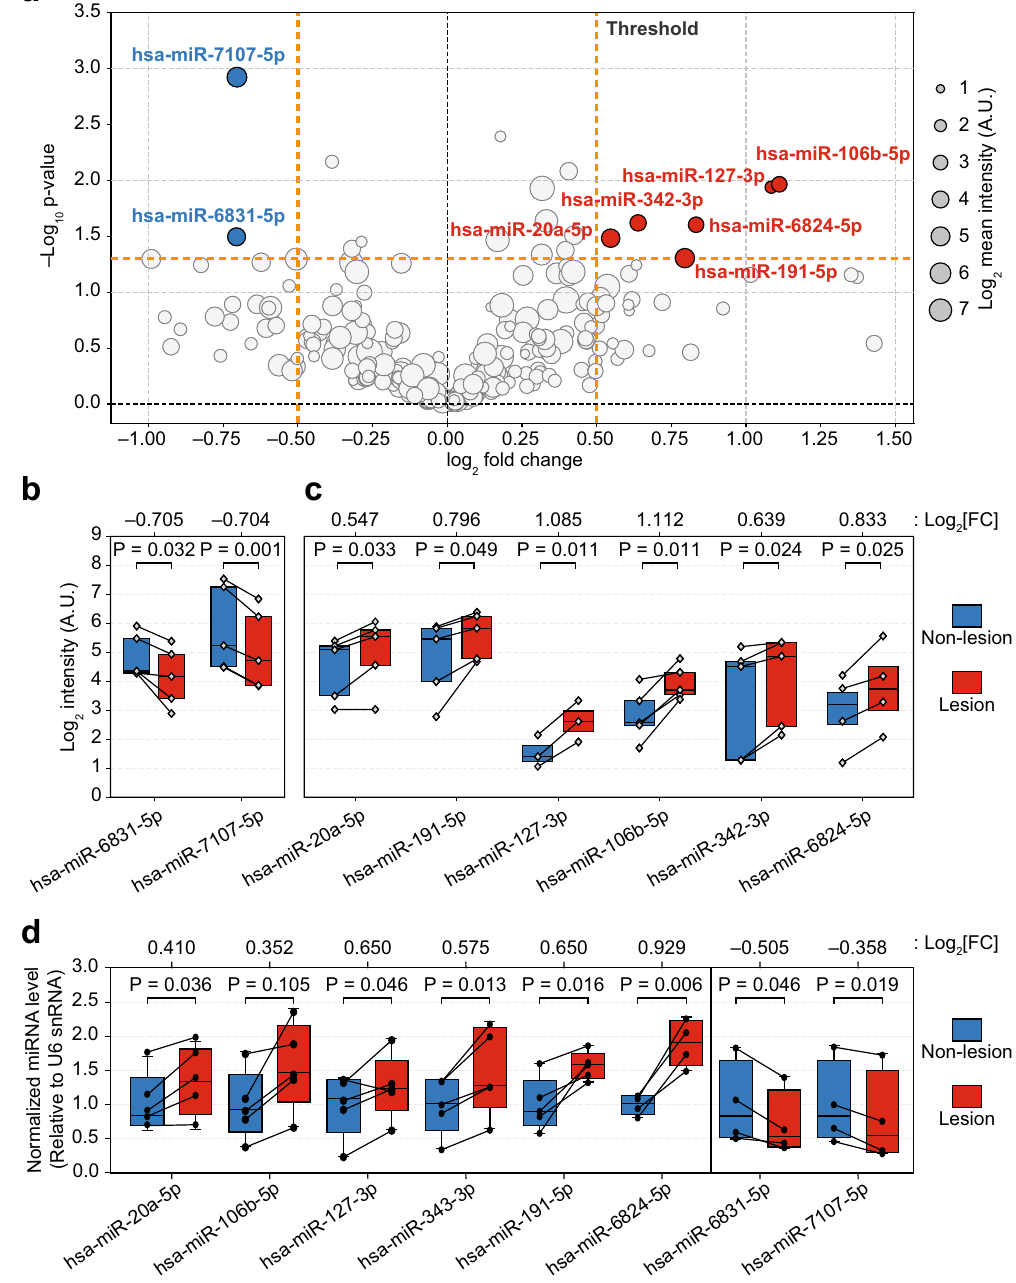
Figure 2. Differentially expressed miRNAs (DEMs) between the lesion and non-lesion samples from patients with SD. ( a ) Volcano plot of − log 10 [ P -value] against log 2 [fold-change, FC], showing the difference in miRNA expression between tissues from the lesion ( n ≥ 3) and non-lesion ( n ≥ 3). Levels of miRNAs marked as red were upregulated in the lesion tissue, and those marked as blue were downregulated. The horizontal dashed line (orange bold) indicates the threshold for statistical significance (paired t -test, P < 0.05), and the vertical dashed lines (orange bold) indicate the threshold FC ( log 2 |FC| > 0.5). The size of the bubbles shows their relative intensities in the microarray. ( b , c ) Box plots represent DEMs in the microarray data. Each diamond symbol indicates each sample. Paired samples are connected to each other (see Supplementary Table S1 online). ( b ) Expression levels of hsa-miR-6831-5p ( n = 5) and hsa-miR-7107-5p ( n = 5). ( c ) Expression levels of hsa-miR- 20a-5p ( n = 5), hsa-miR-191-5p ( n = 5), hsa-miR-127-3p ( n = 3), hsa-miR-106b-5p ( n = 5), hsa-miR-342-3p ( n = 5), and hsa-miR-6824-5p ( n = 4). ( d ) The qRT-PCR verification of the mature miRNA levels. The relative intensity was measured based on the expression levels of the U6 snRNA, an internal control, and further normalized with each L group miRNA level by the mean value of N group miRNA levels. Each dot indicates a sample. Paired samples are connected to each other. P -values (two-tailed Paired t -test) and fold changes ( log 2 |FC| ) are indicated in each